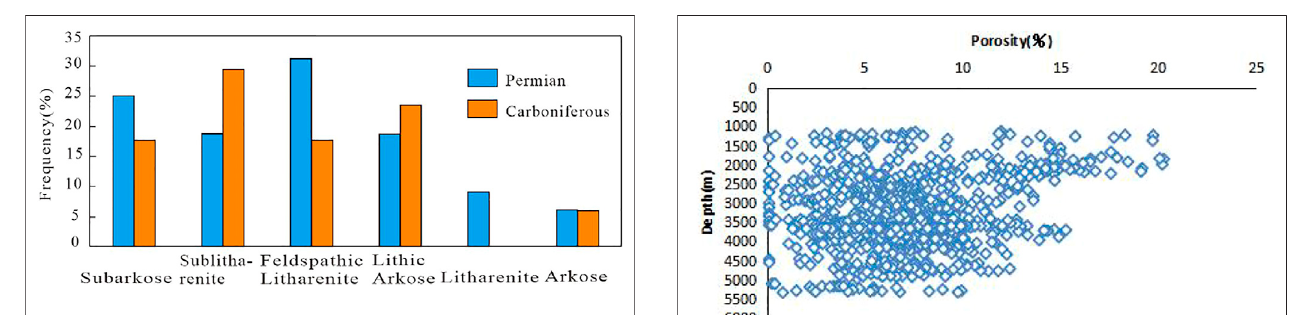
FIGURE 9 | Histograms of rock types within the Upper Paleozoic reservoirs of the Dongpu Depression.